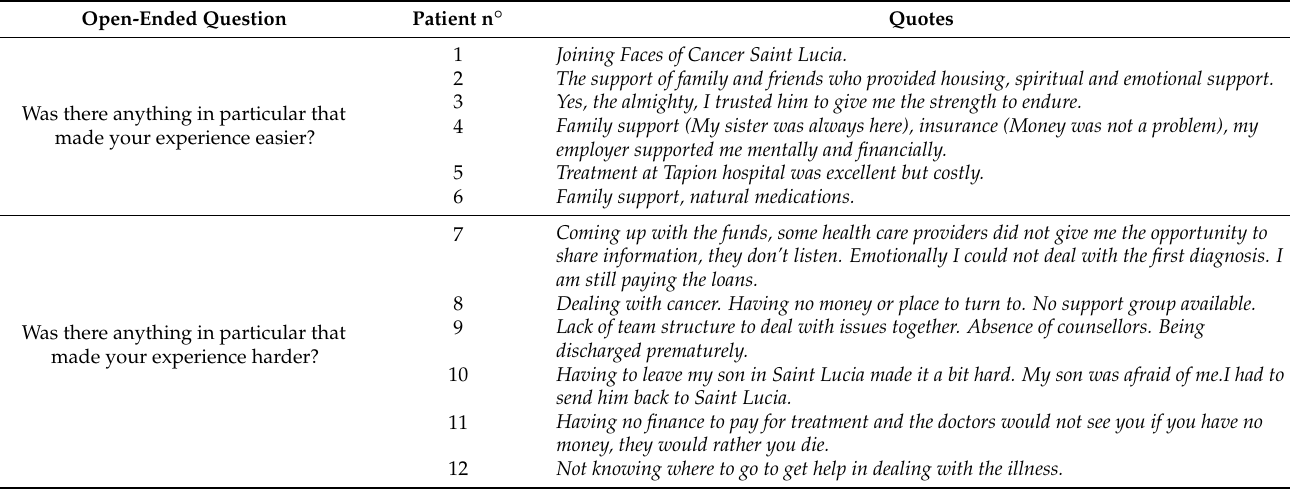
Figure 1. Venn diagram of significant themes emerging from analysis on the responses from the three open-ended questions. Saint Lucia (West Indies), 2019–2020. Each circle represents an open-ended question; the main themes that emerged are written within. The intersection between each circle represents the themes that were common to each question. Themes common to all three open-ended questions are represented in box 1. Positive: “Was there anything in particular that made your experience easier?”, Negative: “Was there anything in particular that made your experience harder?” and Suggestions: “Do you have any suggestions to help improve the experience for other people in similar circumstances?”. HCP: Health care provider. Table 2. Key quotes from participant responses contributing to the development of themes.